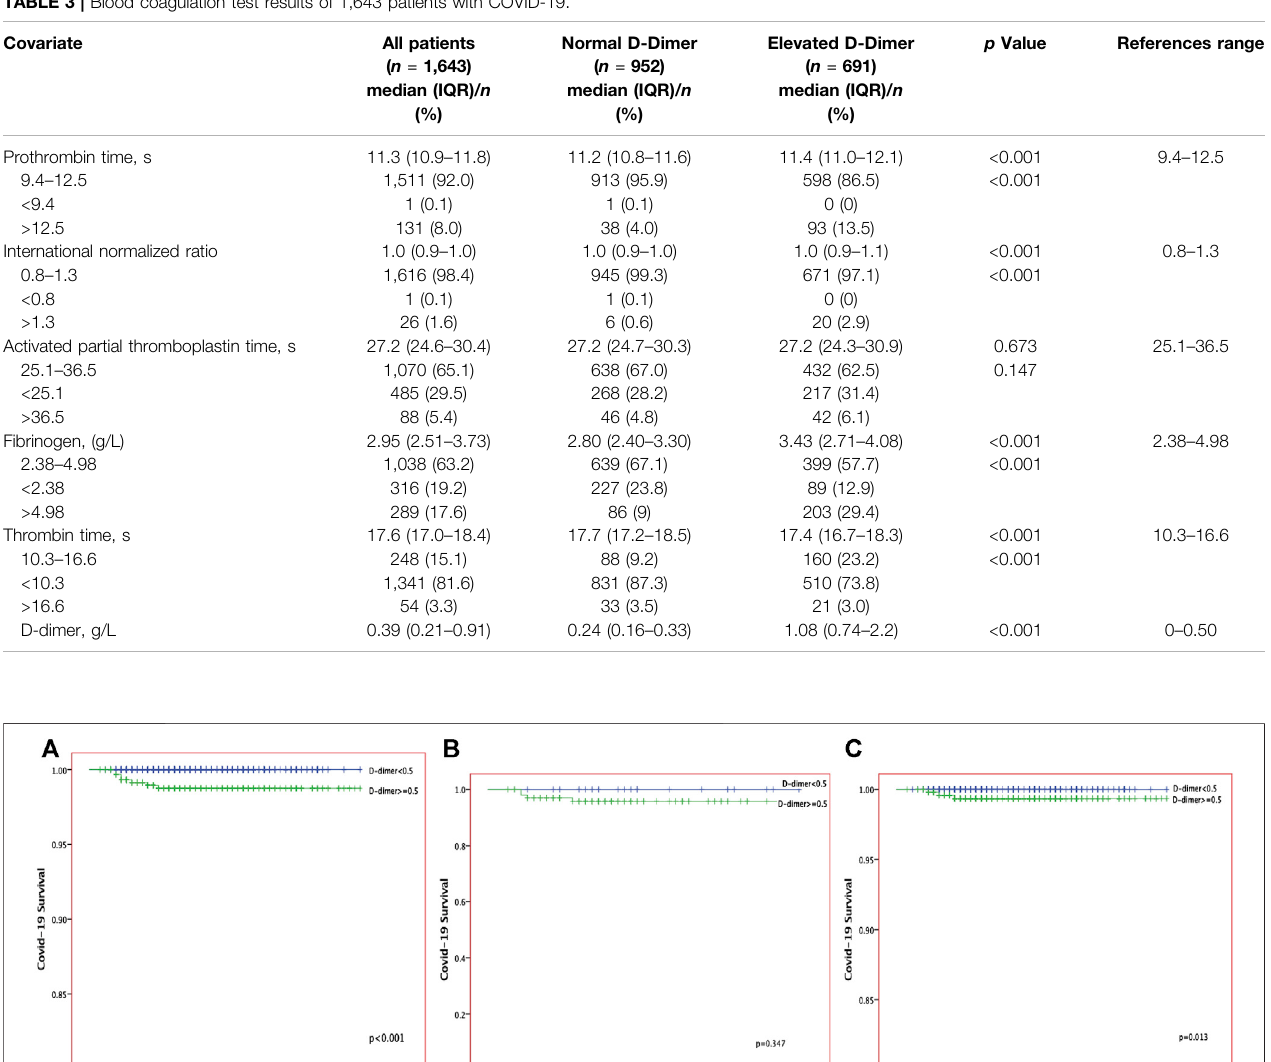
TABLE 3 | Blood coagulation test results of 1,643 patients with COVID-19.